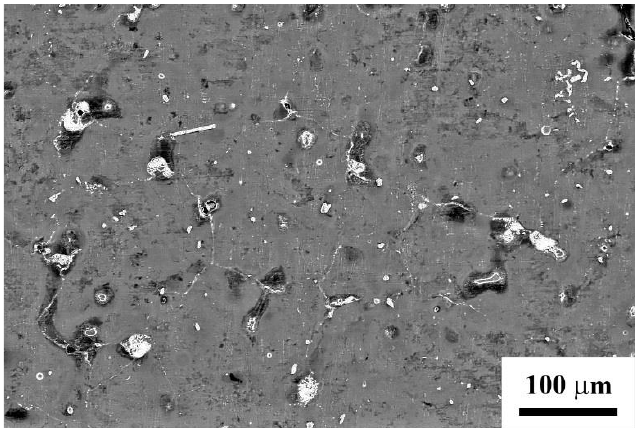
Figure 2. Structure of the initial state of Mg-Al-Zn alloy.